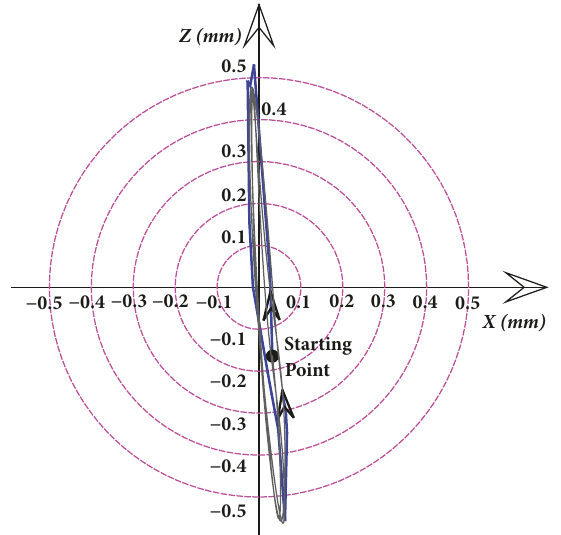
Figure 17: Axis trajectory and variation of rice threshing process.